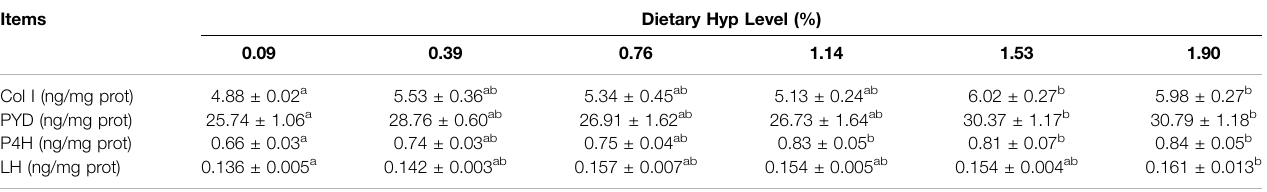
TABLE 9 | The type I collagen (Col I) content, pyridinium crosslink (PYD) content, prolyl 4-hydroxylase (P4H) and lysyl hydroxylase (LH) activity in muscle of ITCC fed with different experimental diets for 8 weeks.